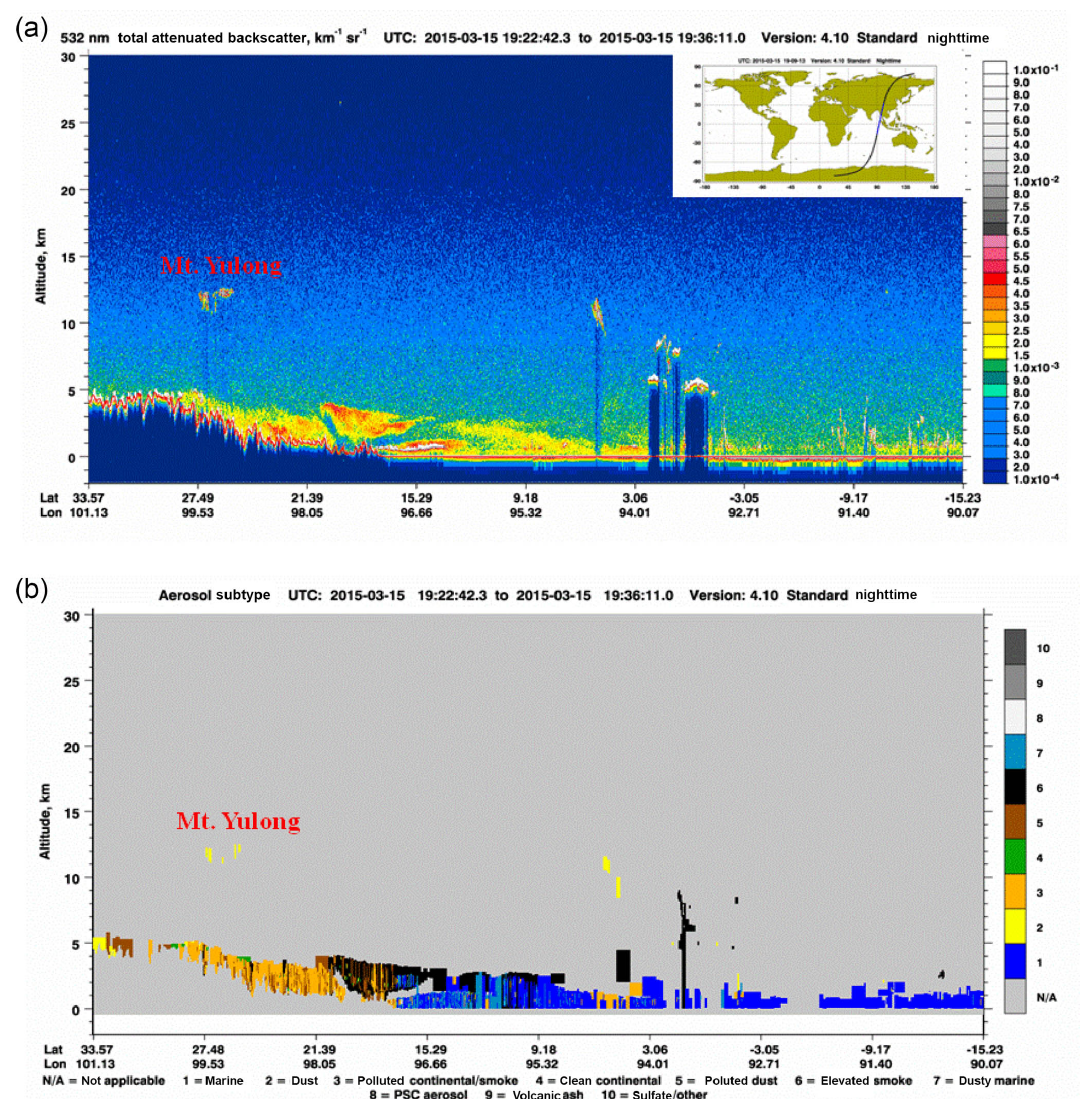
Figure 13. CALIPSO retrieved backscatter signal at 532nm (a) and aerosol subtype information (b) on 15 March 2015. The Mt. Yulong region was covered by a thick aerosol layer (mainly consisting of polluted smoke and dust) in the high atmosphere (above 6000ma . s . l . ), likely transported far from their source regions. CALIPSO profiles were obtained from http://www-calipso.larc.nasa.gov (last access: 6 August 2017). The CALIOP-derived reflectivity is usually taken as an indicator to reflect the structure of atmospheric layers since it is dependent on mass concentration and optical properties of atmospheric aerosol (Bou et al., 2010; Dong et al., 2017a). The topography is outlined by a solid red line. Suspended dust and aerosol pollutants are in orange and